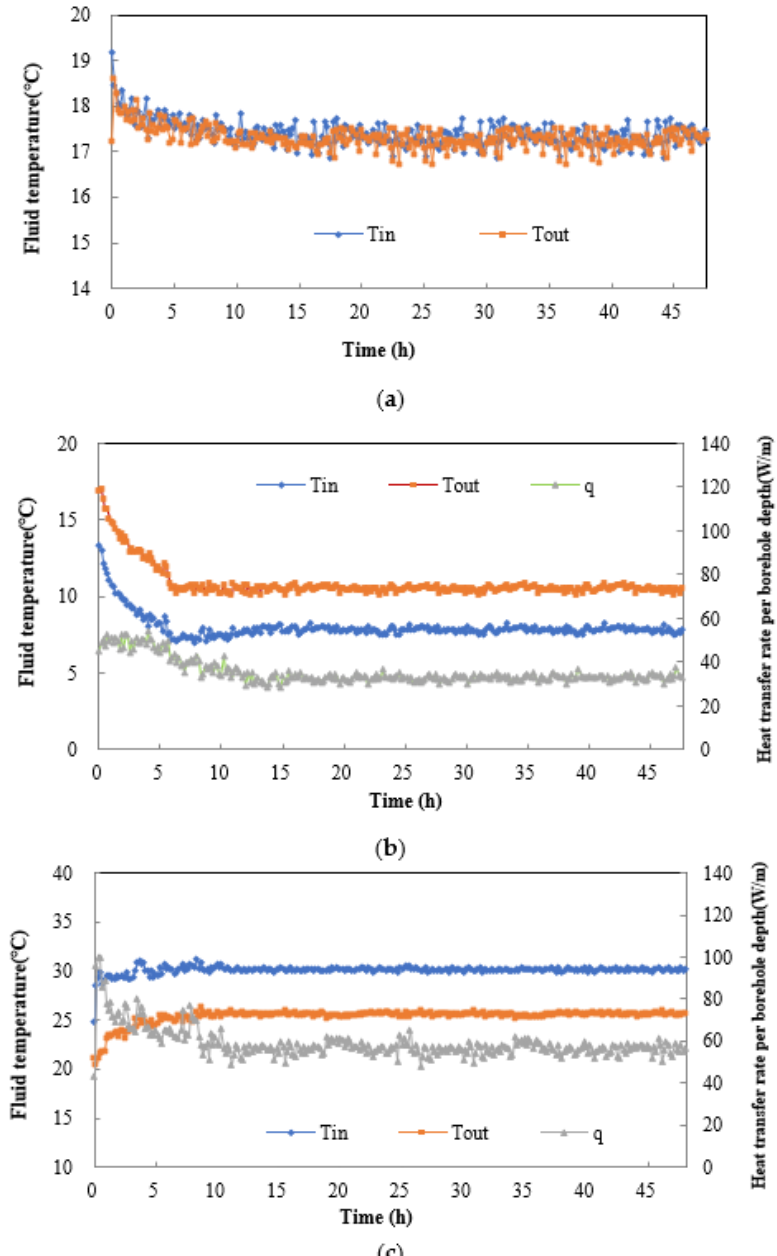
Figure 5. Experimental results under typical heat operation conditions with HS-1: ( a ) without heating or cooling; ( b ) heat extraction ( T in : 7.83 °C); and ( c ) heat injection ( T in : 30.20 °C).